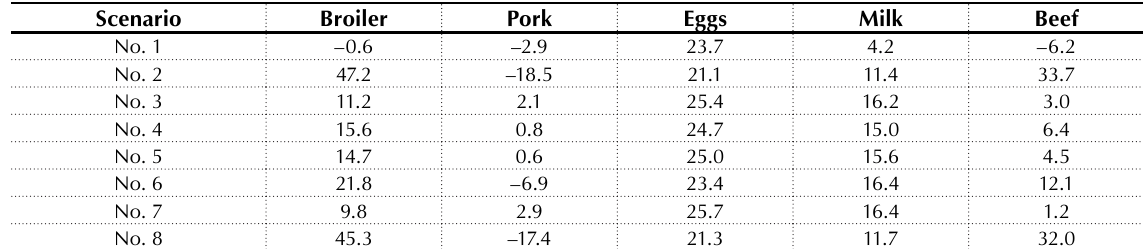
Source: Calculated by the